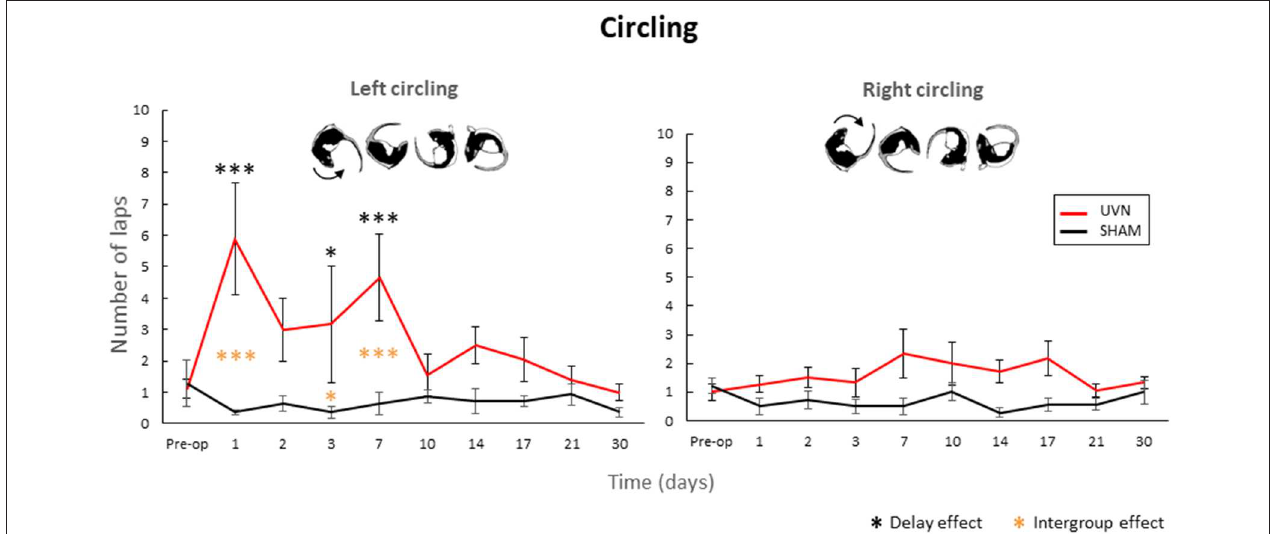
FIGURE 4 | Quantification of the circling behavior. The UVN group performed significantly more left circling at D1, D3, and D7 compared to the preoperative period and the SHAM group (0.05 < p < 0.0001). Concerning the number of right-hand turns, no significant difference is observed between the SHAM and UVN groups. This circling behavior is never observed in the SHAM group. Standard errors of the mean are reported as vertical lines. Delay effect refers to significative differences with the preoperative condition; intergroup effect means that a significative difference was found between UVN and SHAM group (* p < 0.05; *** p < 0.001).